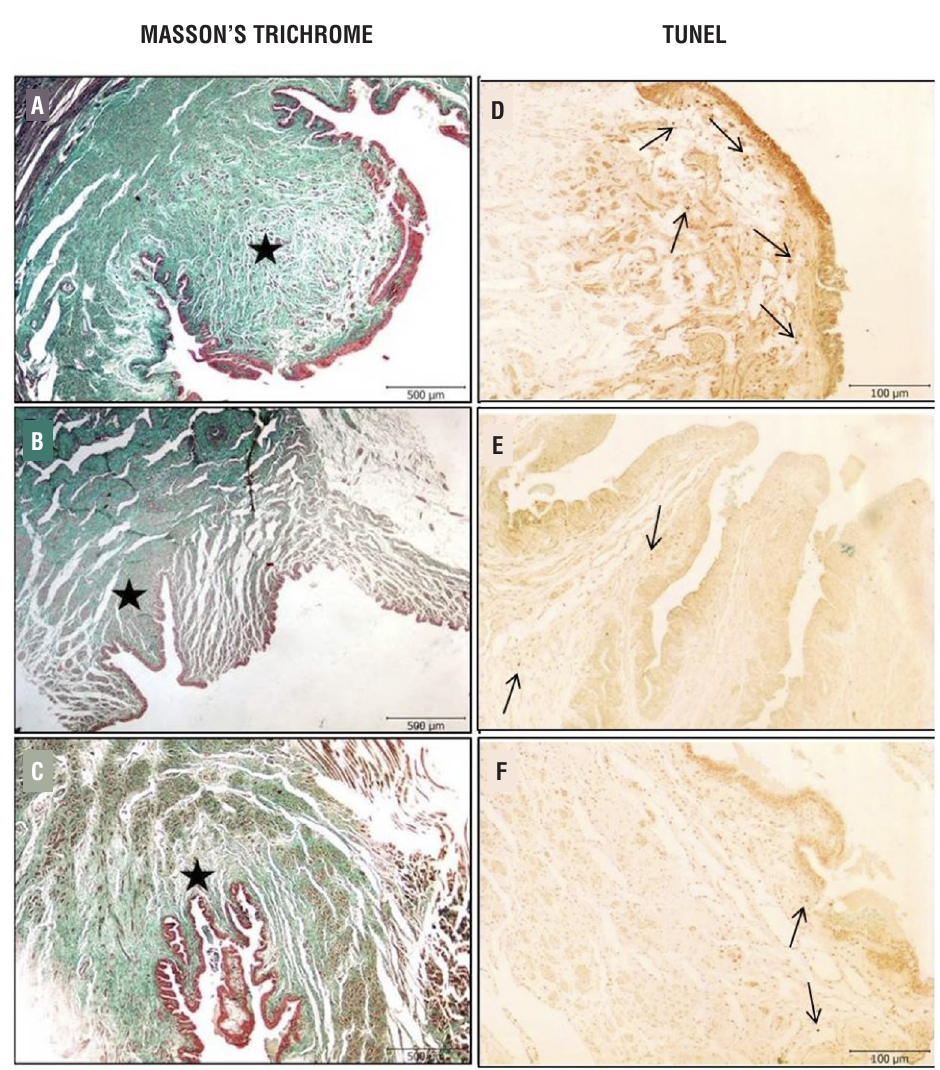
Figure 2 - Representative urethra tissue photographs of Masson’s trichrome and TUNEL